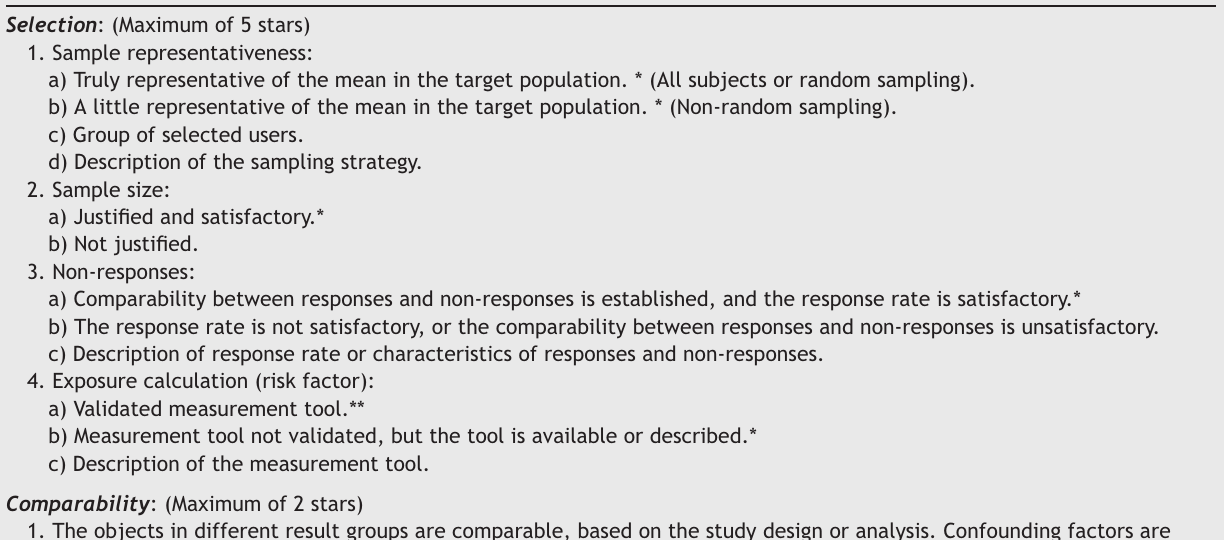
Newcastle-Ottawa Scale (adapted) for quality assessment of cross-sectional